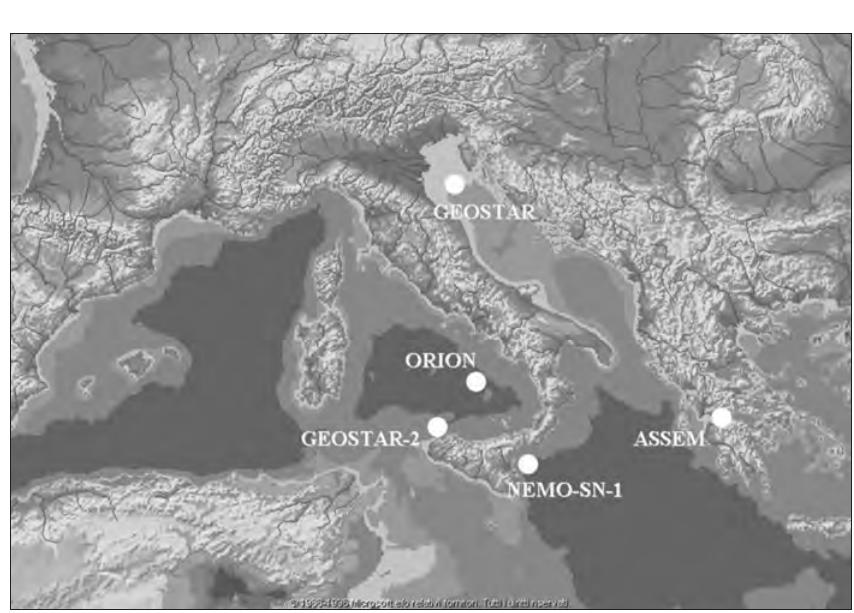
Fig. 10. Map of the seafloor experiments performed with GEOSTAR-class platforms, see table VI for